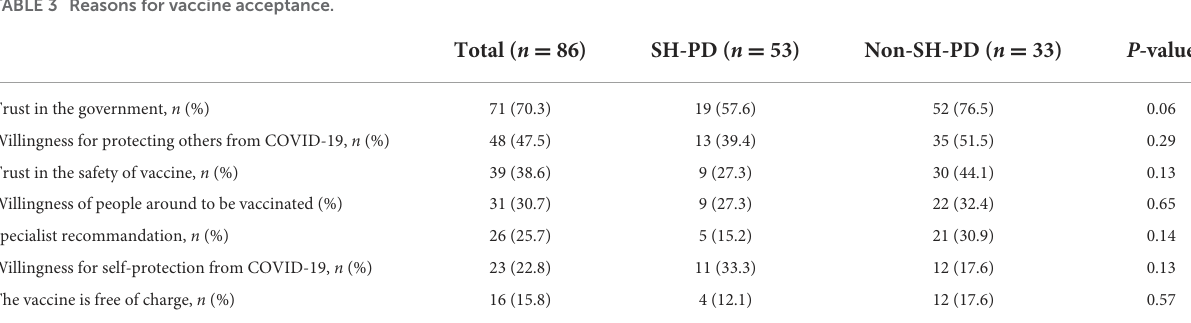
TABLE 3 Reasons for vaccine acceptance.